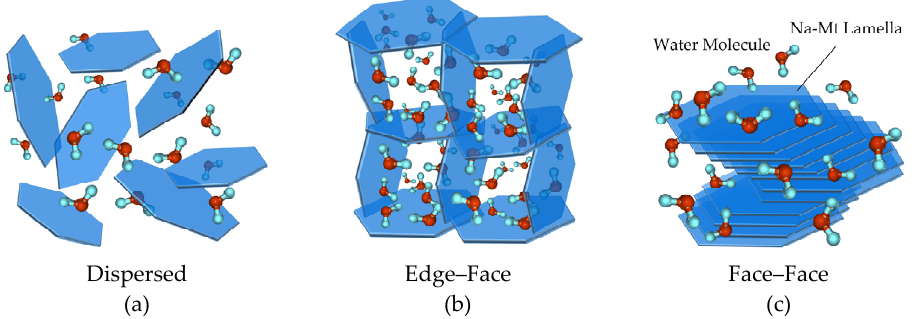
Figure 12. Schematic diagrams of the dispersed and aggregated modes of Na-Mt particles in suspensions and distribution of water molecules: ( a ) dispersed state; ( b ) aggregated Edge–Face mode; ( c ) aggregated Face–Face mode.